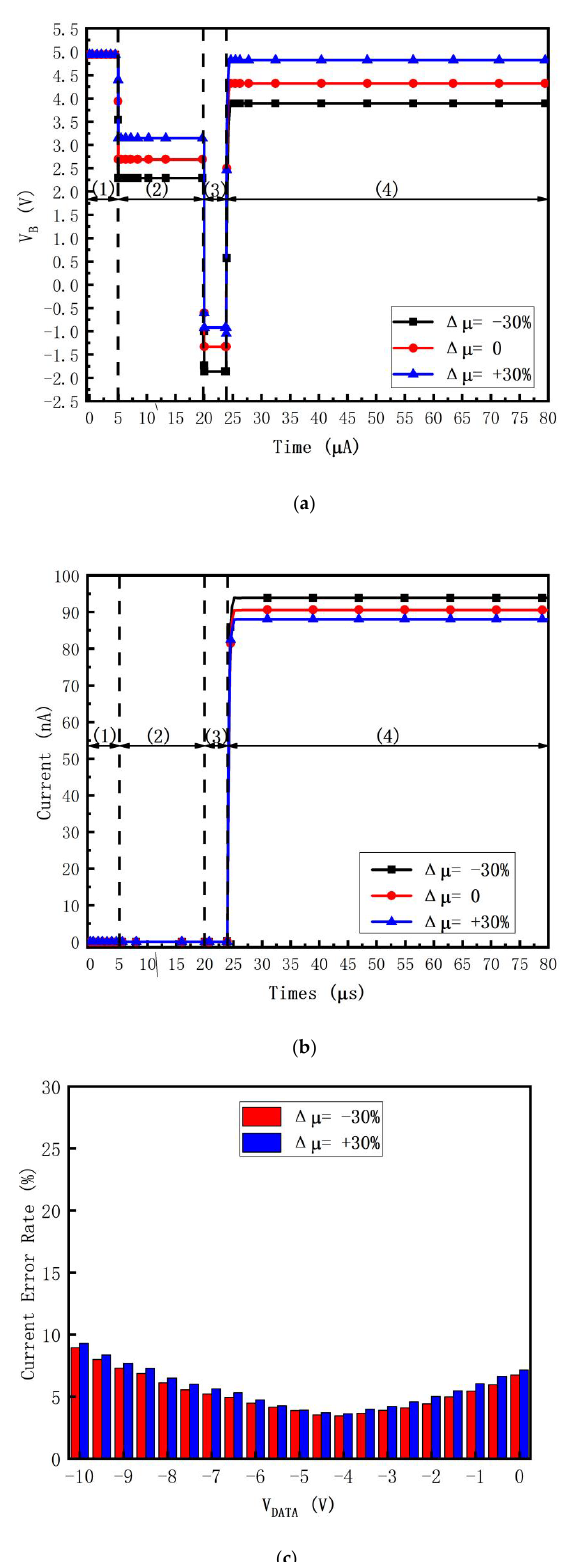
Figure 6. Transient waveforms of ( a ) V B and ( b ) I OLED when Δu = +30%, 0, and −30% at V DATA = −4V, where (1) initialization stage, (2) threshold voltage extraction stage, (3) data input stage, (4) emission stage, and ( c ) current error rates versus V DATA when the threshold voltage varies. The CER for Δu is defined as